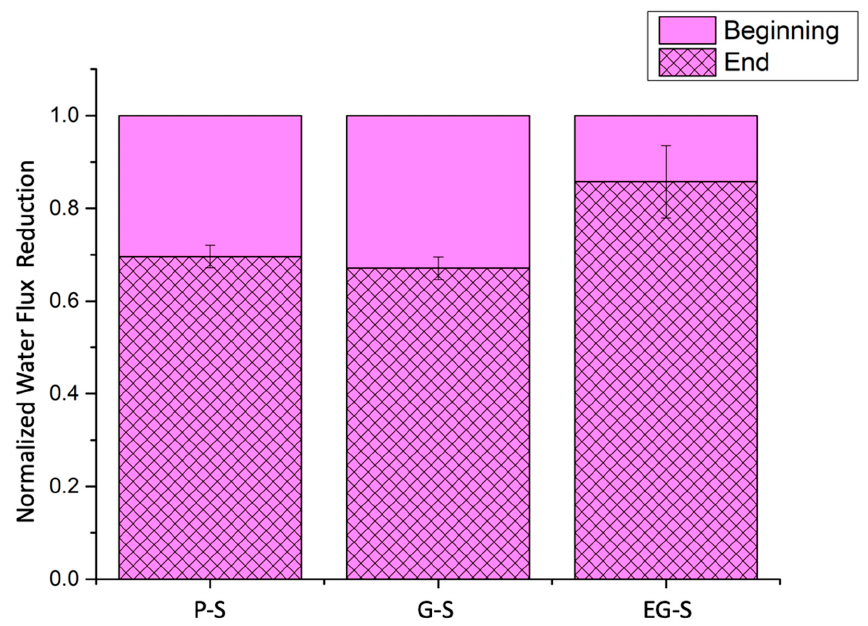
Figure 4. Normalized water flux reduction for the P-S, G-S, and EG-S membranes.